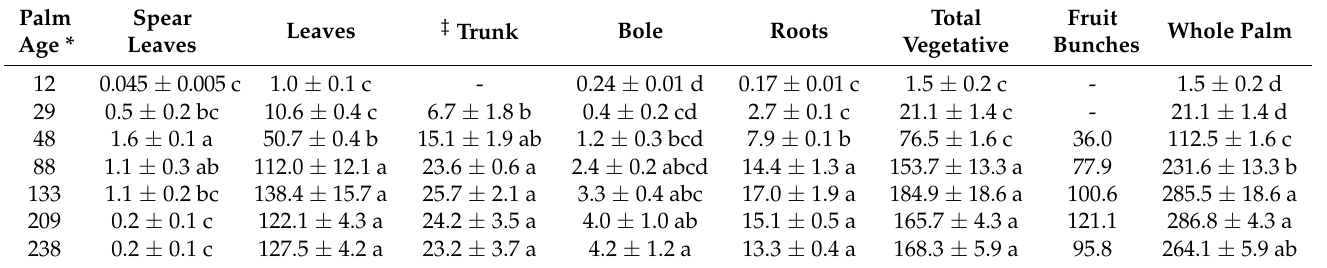
Table 4. Dry matter (mean ± SE) incorporated in vegetative tissues (kg palm − 1 year − 1 ) and fruit bunches of tenera oil palm. No SE values were calculated for fruit bunches, since the weight of fruit bunches was obtained from the actual bunch weight recorded in a single